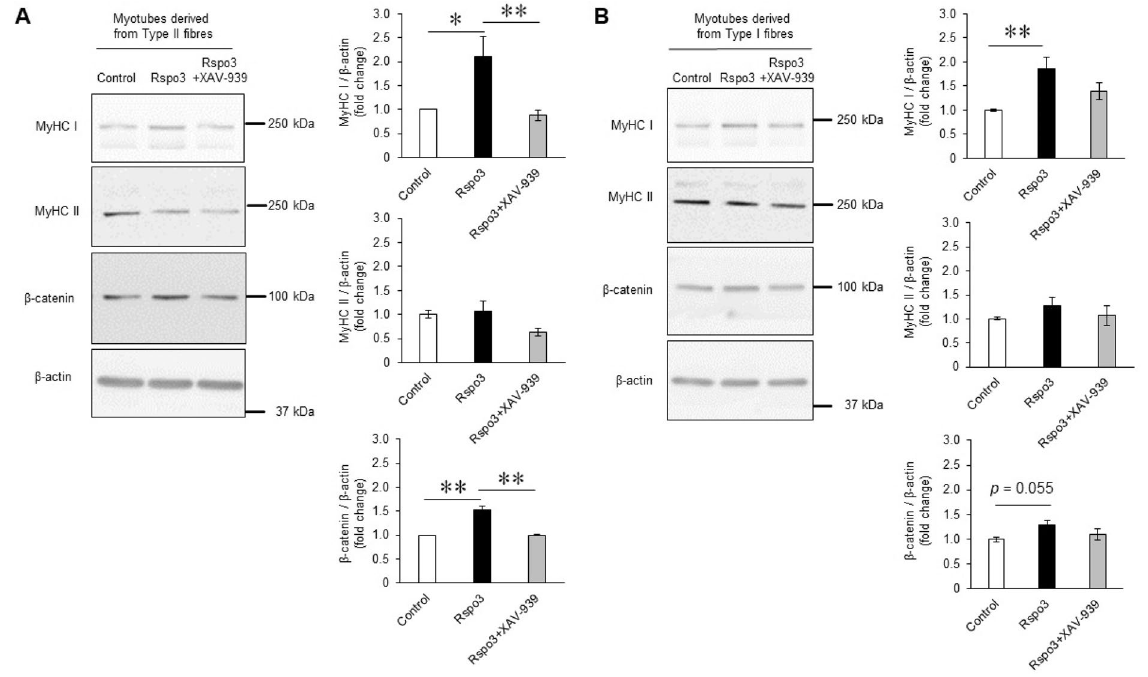
Figure 5. The Rspo3-induced MyHC I expression is blocked by a pharmacological inhibitor of the Wnt/β- catenin signalling pathway. ( A , B ) Mouse primary myoblasts were differentiated in the medium containing the Rspo3 recombinant protein (200 ng/mL; 6.45 nM) with or without the WNT/β-catenin signalling inhibitors, XAV-939 (1.56 µg/mL; 5 µM), for 3 d. Protein levels of β-catenin, MyHC I and MyHC II in myotubes were quantified using Western blotting. Values are presented as mean ± SEM (n = 6–7 mice for analysing cells derived from type II fibres, n = 9–10 mice for analysing cells derived from type I fibres). ( A ) Myoblasts derived from type II fibre were used. ( B ) Myoblasts derived from type I fibre were used. * P < 0.05; ** P < 0.01 by one-way ANOVA followed by the Tukey post hoc test. Uncropped blots can be found in Supplementary Fig.